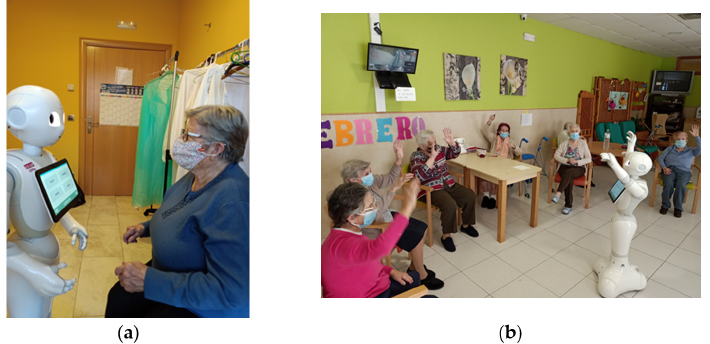
Figure 7. Users interacting with the robot in Lacort elder care facility individually ( a ) and performing exercises in group ( b ).